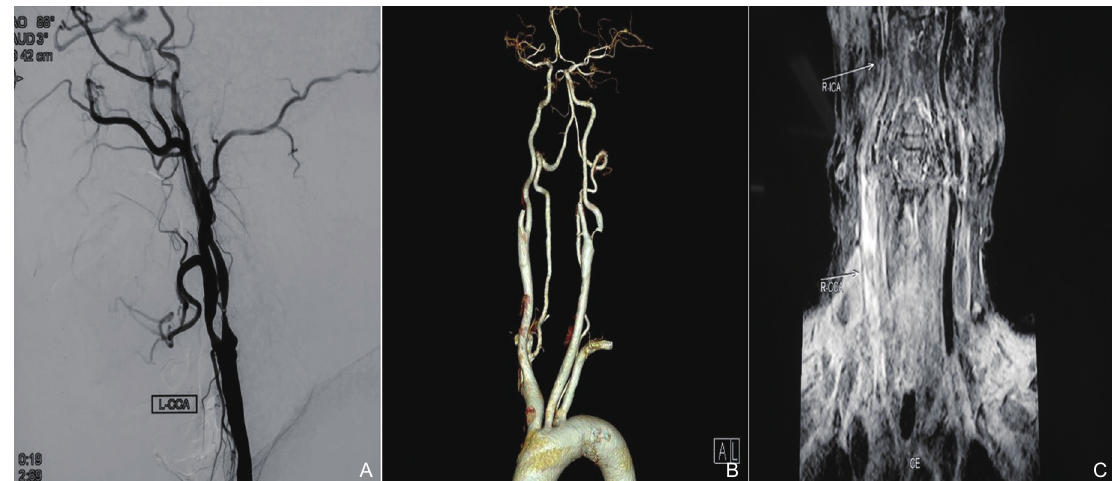
A Figure 1 Different imaging modalities for cerebrovascular. (A) The severe stenosis was shown in the left internal carotid artery in DSA; (B) The severe stenosis was illustrated in the left internal carotid artery in CTA; (C) The near occlusion was shown in the right common carotid artery in high-resolution MRA.